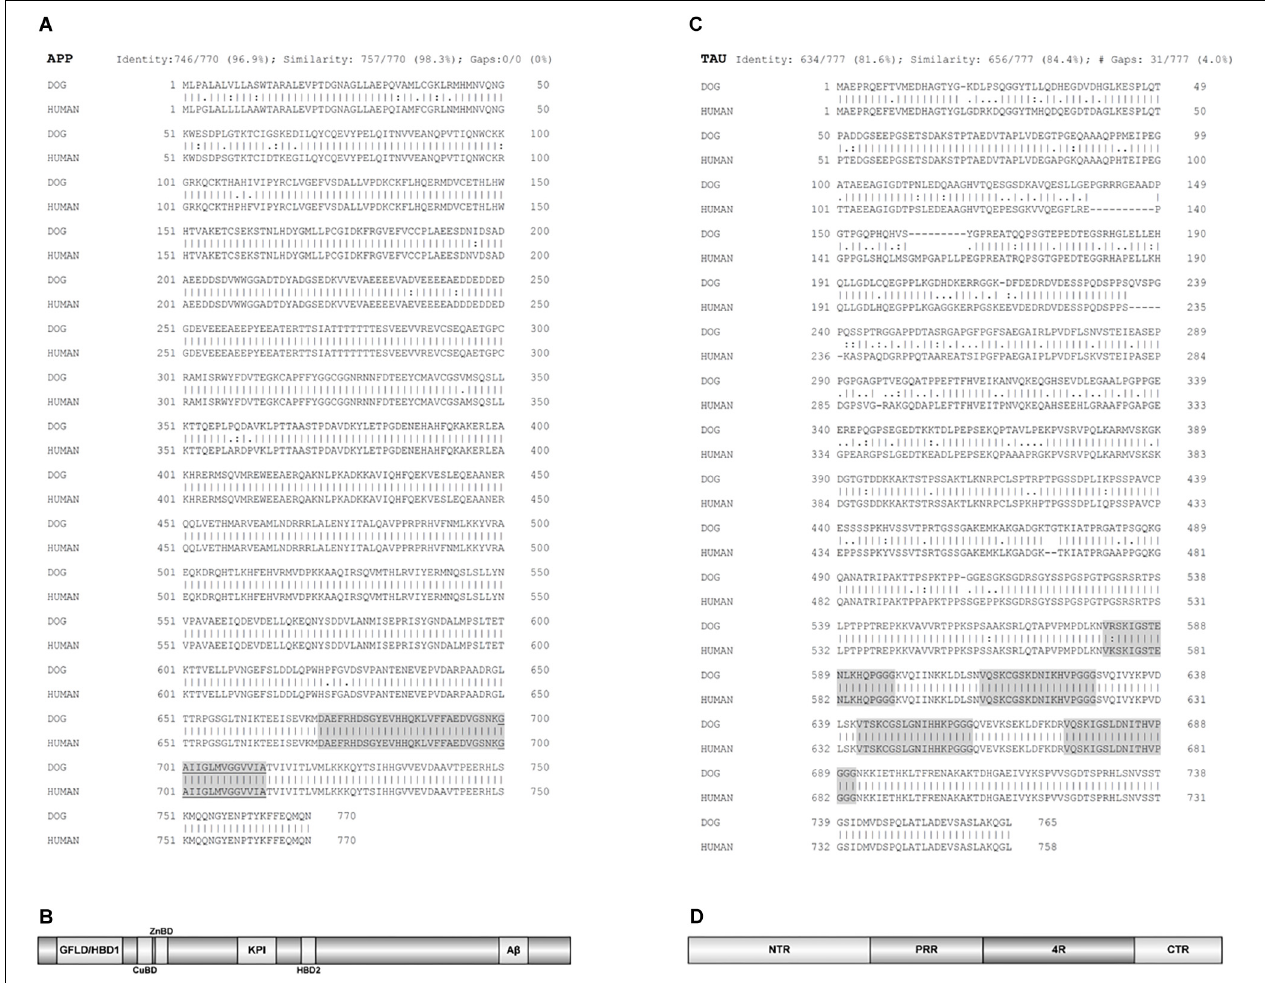
FIGURE 1 | Protein sequences alignments between dog and human amyloid-beta precursor protein (APP) and TAU. (A) The alignment of the longest canine APP isoform (APP-770) sequence with protein sequence of human APP. Aligned sequences share 96.9% amino acid identity and 98.3% similarity. Of note, the sequence identity of canine APP-695 isoform, the predominant APP isoform in the canine brain, and human APP is 87.5%. Highlighted is A β domain and underlined the membrane bound part of this domain. (B) Domain structure of APP. Isoform APP-770 is depicted. HBD1/GFLD, heparin binding domain 1/growth factor like domain; CuBD, copper binding domain; ZnBD, zinc binding domain; KPI, Kunitz-type protease inhibitor domain (not present in APP-695); A β , amyloid beta domain, the latter anchors APP in the cell membrane. The α -, β -, and γ -secretase cleavage sites are directly adjacent or inside the A β domain region, which is also most mutation prone, thus enabling alternative cleavage of APP and its divergent aggregation propensities. (C) Alignment of the longest TAU protein isoform, out of six existing, of dog and human TAU. Aligned TAU sequences share 81.6% amino acid identity and 84.4% similarity. Highlighted are four microtubule-binding regions (4R). (D) Domain structure of TAU. The basic organization is shown. NTR, N-terminal region; PRR, proline-rich region; 4R, four microtubule-binding regions (some isoforms have three); CTR, C-terminal region. The PRR and 4R domains are subject of most posttranslational modifications, while the CTR enables interactions with microtubules and plasma membrane. EMBOSS Needle pairwise sequence alignment (Madeira et al., 2019) was performed. A line (|) indicates positions which have a single, fully conserved residue. A colon (:) indicates conservation between groups of strongly similar properties and a dot (.) indicates conservation between groups of weakly similar properties. The domain organization was depicted by software illustrator of biological sequences (IBS) (Liu et al., 2015). Figure made by the